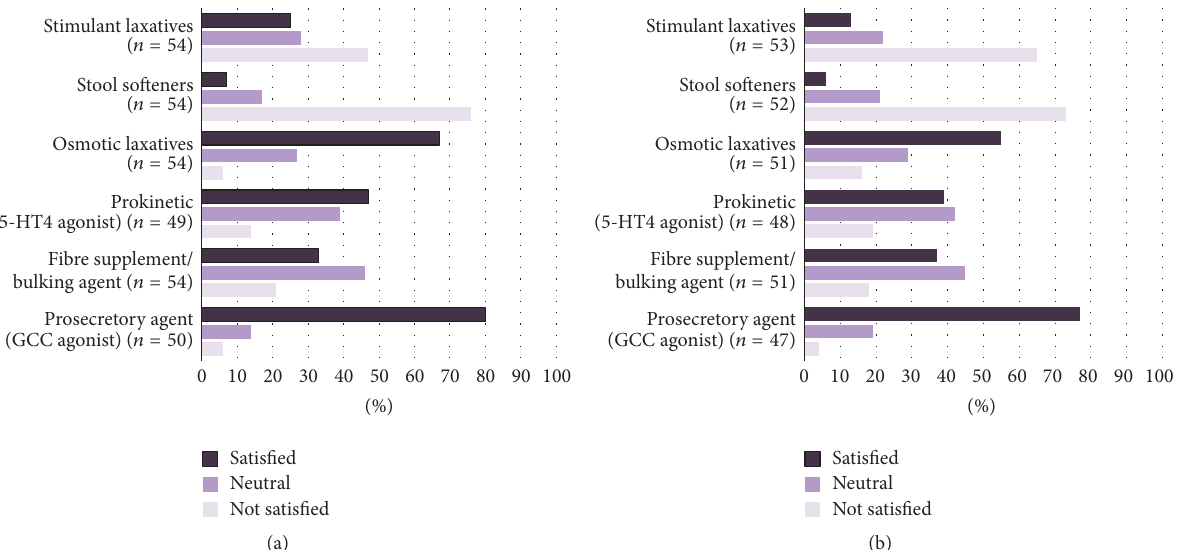
Figure 2: (a) Respondents’ satisfaction with treatment options for managing patients with CIC. Stool softeners and stimulant laxatives ( 𝑝 = 0.0002 ) were found to be unsatisfying treatments for CIC compared to other options. On the other hand, GCC agonist ( 𝑝 < 0.0001 ), osmotic laxatives ( 𝑝 < 0.0001 ), 5-HT4 agonist ( 𝑝 = 0.0003 ), and fibre supplements/bulking agents ( 𝑝 = 0.0069 ) were considered to be satisfying treatments for CIC among the treatment options being surveyed. (CIC : chronic idiopathic constipation; GCC : guanylyl cyclase C.) (b) Respondents’ satisfaction with treatment options for managing patients with IBS-C. Both stool softeners ( 𝑝 < 0.0001 ) and stimulant laxatives ( 𝑝 = 0.038 ) were unsatisfying treatments for IBS-C compared to other options, whereas GCC agonist ( 𝑝 < 0.0001 ), osmotic laxatives ( 𝑝 < 0.0001 ), 5-HT4 agonist ( 𝑝 = 0.003 ), and fibre supplements/bulking agents ( 𝑝 = 0.004 ) were considered to be satisfying treatments for IBS-C among the treatment options being surveyed. (IBS-C : constipation-predominant irritable bowel syndrome; GCC : guanylyl cyclase C) .